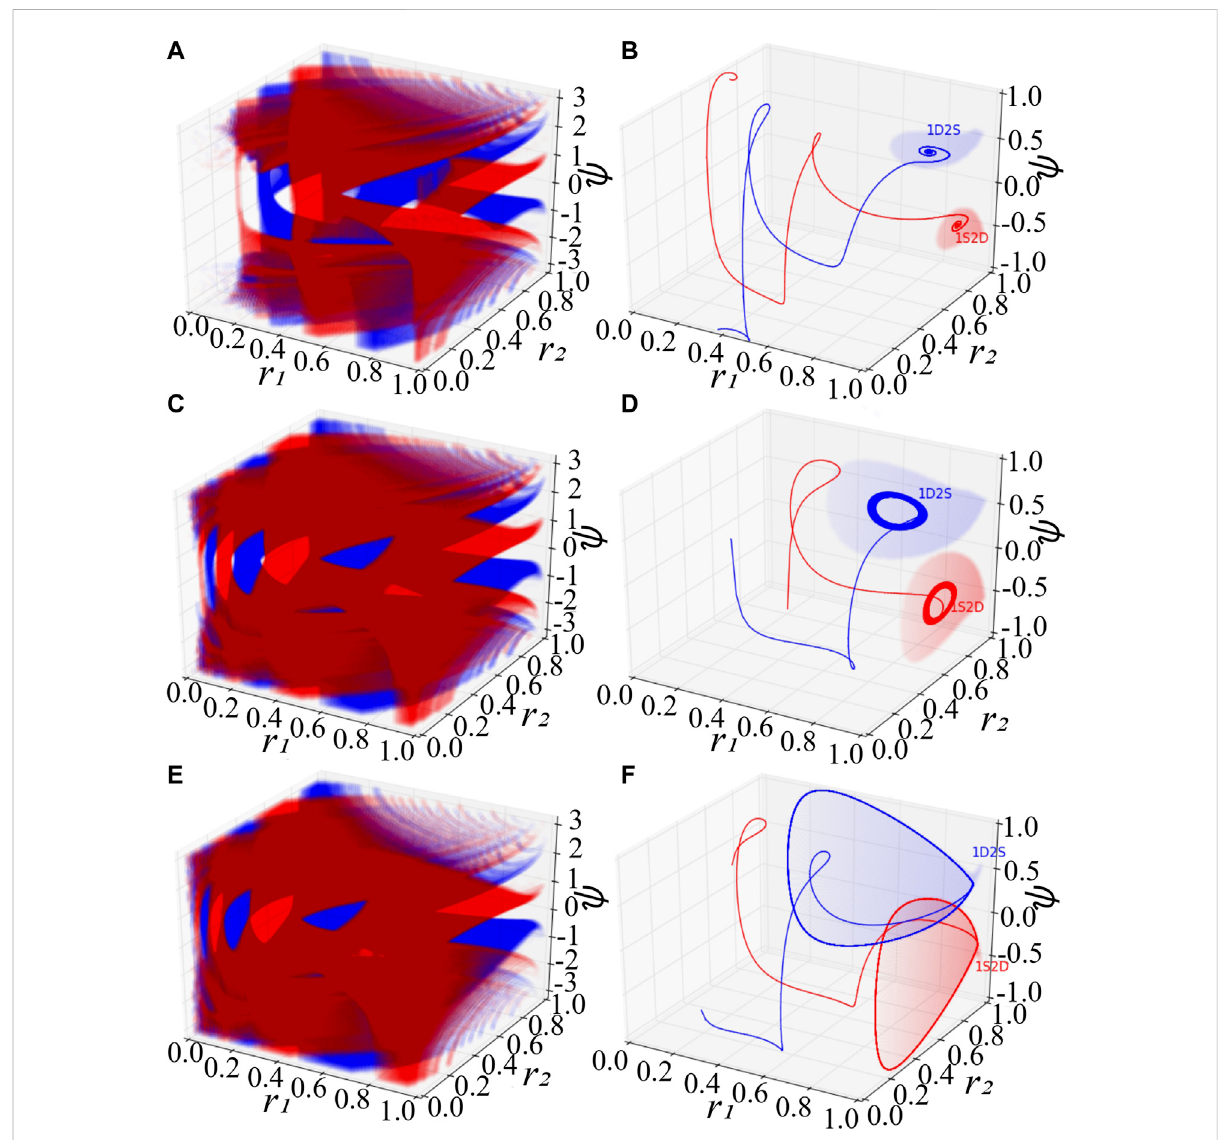
FIGURE 1 Basins ofattraction ofchimerastates for thelow-dimensional system Eq.7. (A,B) The stable chimera states. (C,D) The breathingchimera states. (E,F) The long-period breathing chimera states. In (A) , (C) , and (E) , the red and blue color denote respectively the basins of attraction of 1S2D and 1D2S. The notations 1S2D represent that the fi rst population is synchronized and the second is desynchronized, and 1D2S denote that the fi rst population is desynchronized and the second is synchronized. Mathematically, 1S2D with r 1 = 1 and r 2 < 1, and 1D2S with r 1 < 1 and r 2 = 1. In (B) , (D) and (F) , red and blue solid lines are trajectories with random initial conditions inside the red and blue attracting basins respectively. Red and blue areasin (B) , (D) and (F) show thespecialattractingbasinswiththeinitialconditions r 1 =1and r 2 =1respectively. Forthesimulation, weset β =0.1, A = 0.20 in (A,B) , A = 0.28 in (C,D) , and A = 0.35 in (E,F)